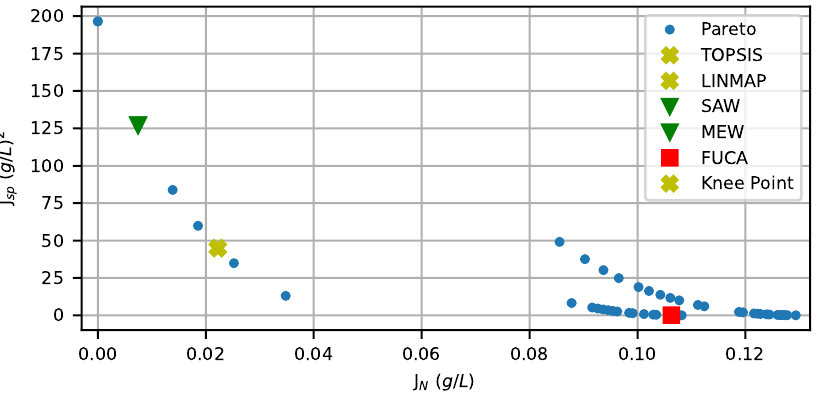
Figure 5. Pareto front with DAP addition at t = 0 h and t = 48 h. Total of 50 points with 0.05 step. The points corresponding to α = 0 and α = 1 are